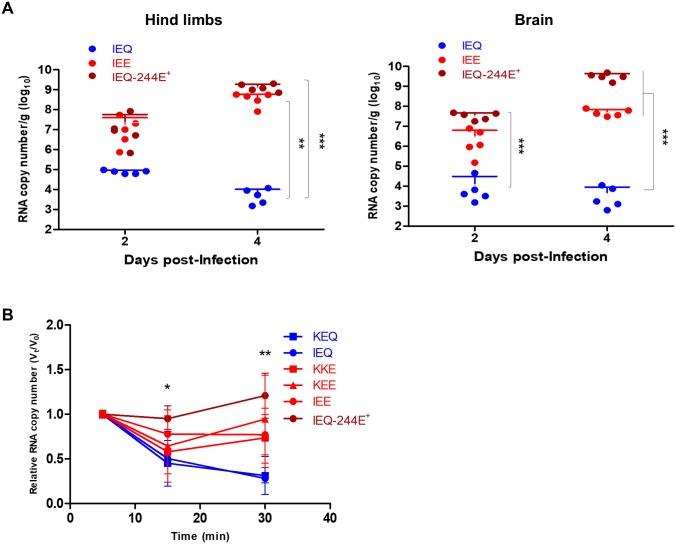
Viral load quantitation from harvested organs and viremia level induced by EV-A71 variants.(A) At selected time points, IEQ, IEE and IEQ-244E+-infected mice (n = 5) were sacrificed and viral loads were determined from harvested hind limbs and brains using qRT-PCR. Significant differences between viral variants are labelled as ** (P < 0.01) and *** (P < 0.001). (B) Virus clearance from blood was quantitated using qRT-PCR following intravenous inoculation of KEQ, KKE, KEE, IEE, IEQ or IEQ-244E+ into 3–4 weeks old mice. The viral RNA copies were quantitated at selected timepoints up to 30 minutes. The data are presented as Vt/V0, indicating the fraction of viral RNA copies at each timepoint (Vt) over the initial viral RNA copies (V0). Significant differences between KEQ and IEQ-244E+ are labelled as * (P < 0.05) and ** (P < 0.01).